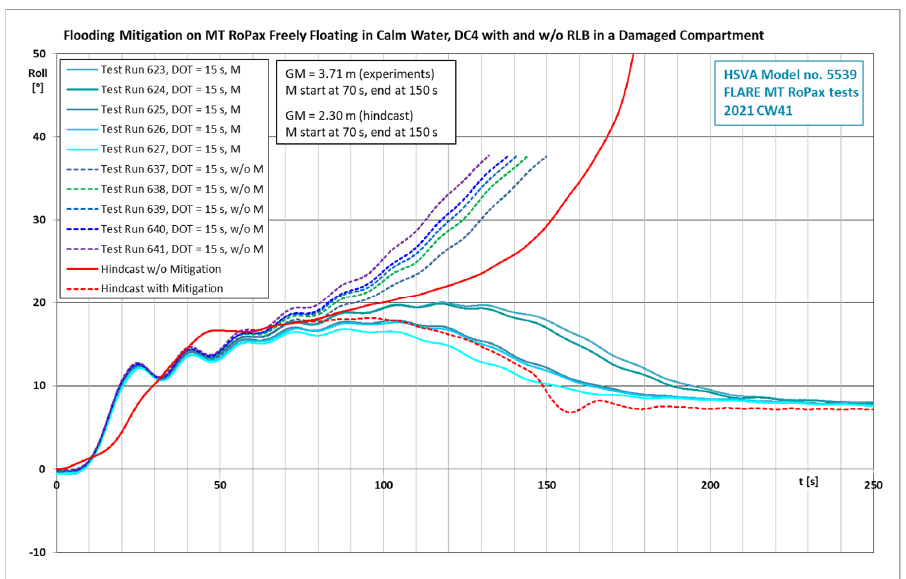
Figure 15. Damage Case 4 with damage opening time 15 s: Roll angle as a function of time with (solid lines) and without (dashed lines) recovery of lost buoyancy in the damaged compartment T045. The red solid line shows the numerical hindcast without mitigation, the dashed red line the hindcast with mitigation.